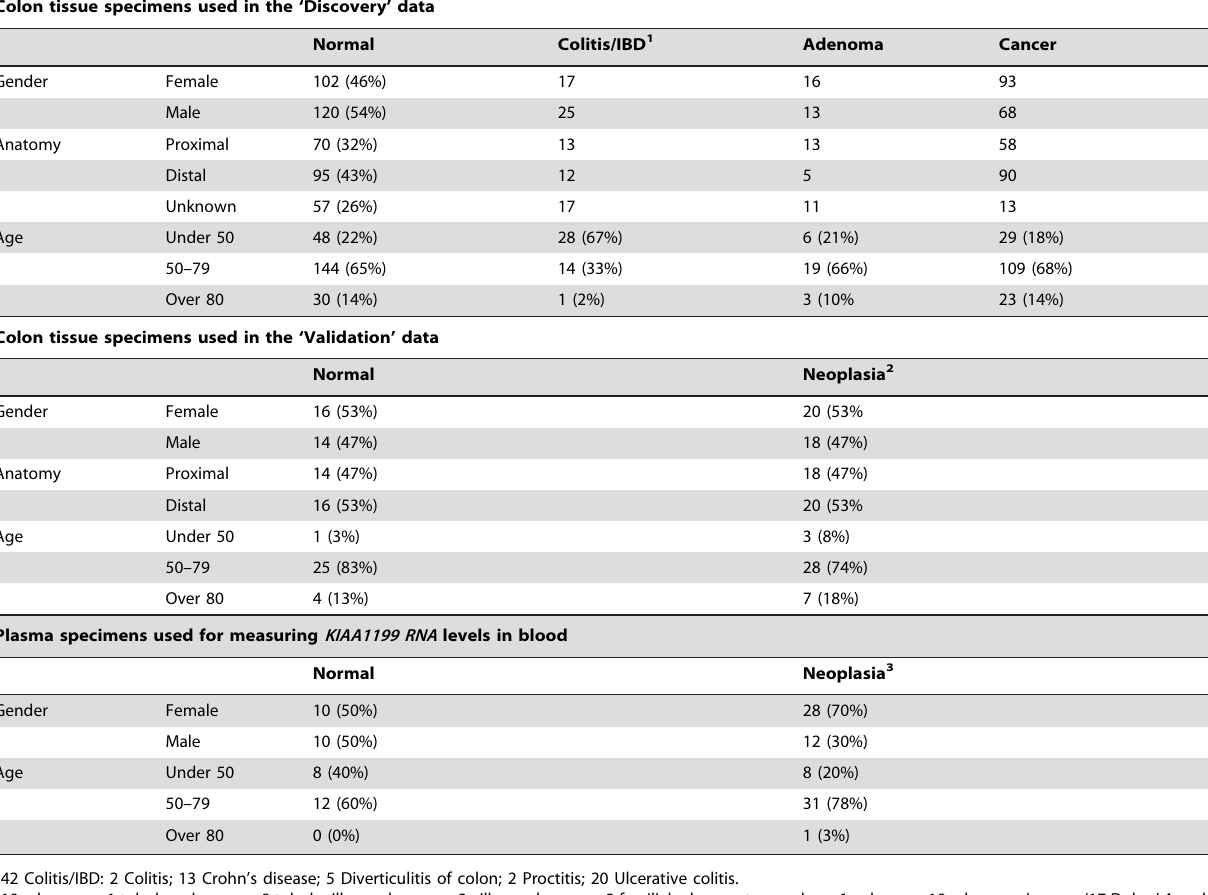
Table 3. Phenotypic breakdown of clinical specimens used in this study.